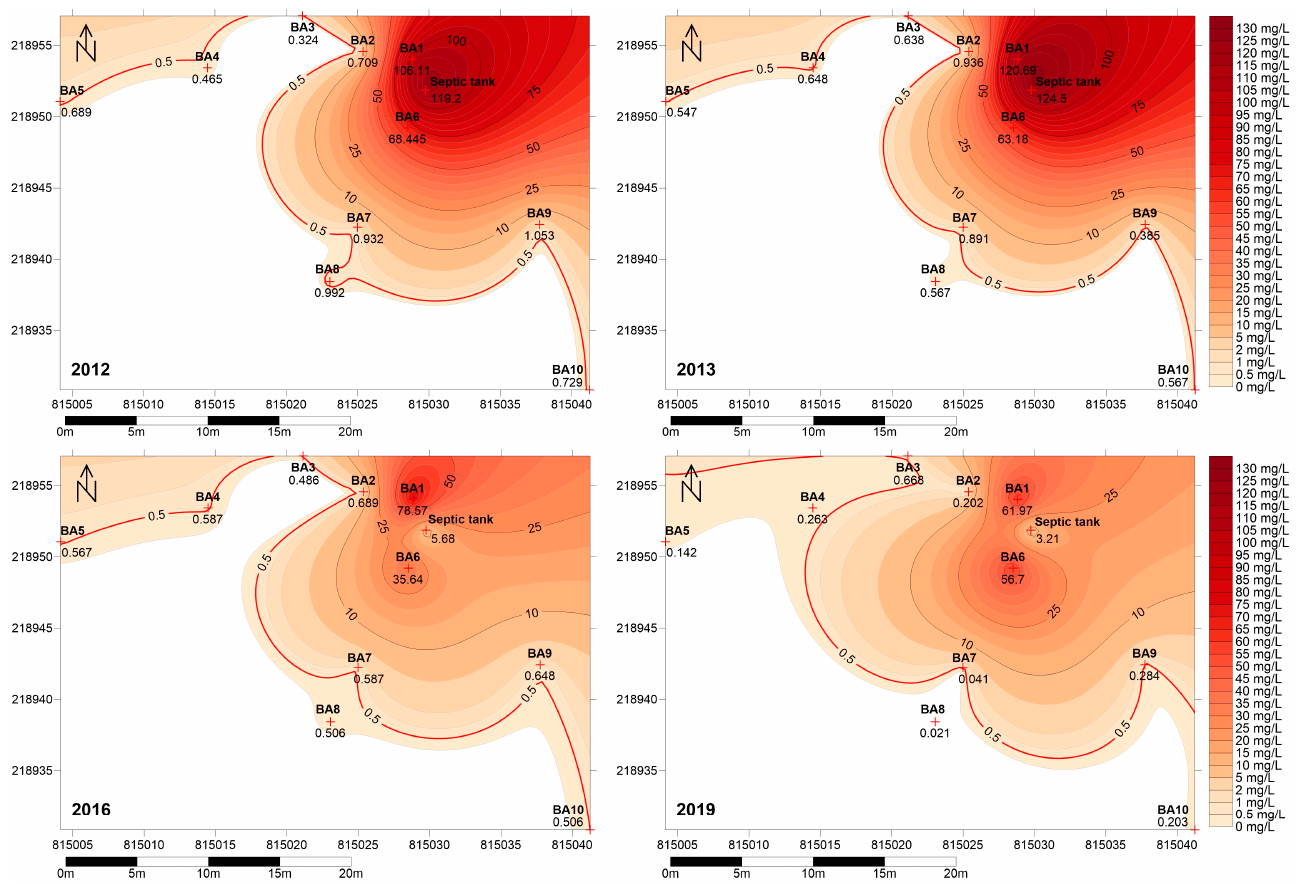
Figure 6. Spatial distribution maps of NH 4+ concentrations in the years before (2012, 2013) and after (2016, 2019) the elimination of the septic tank.